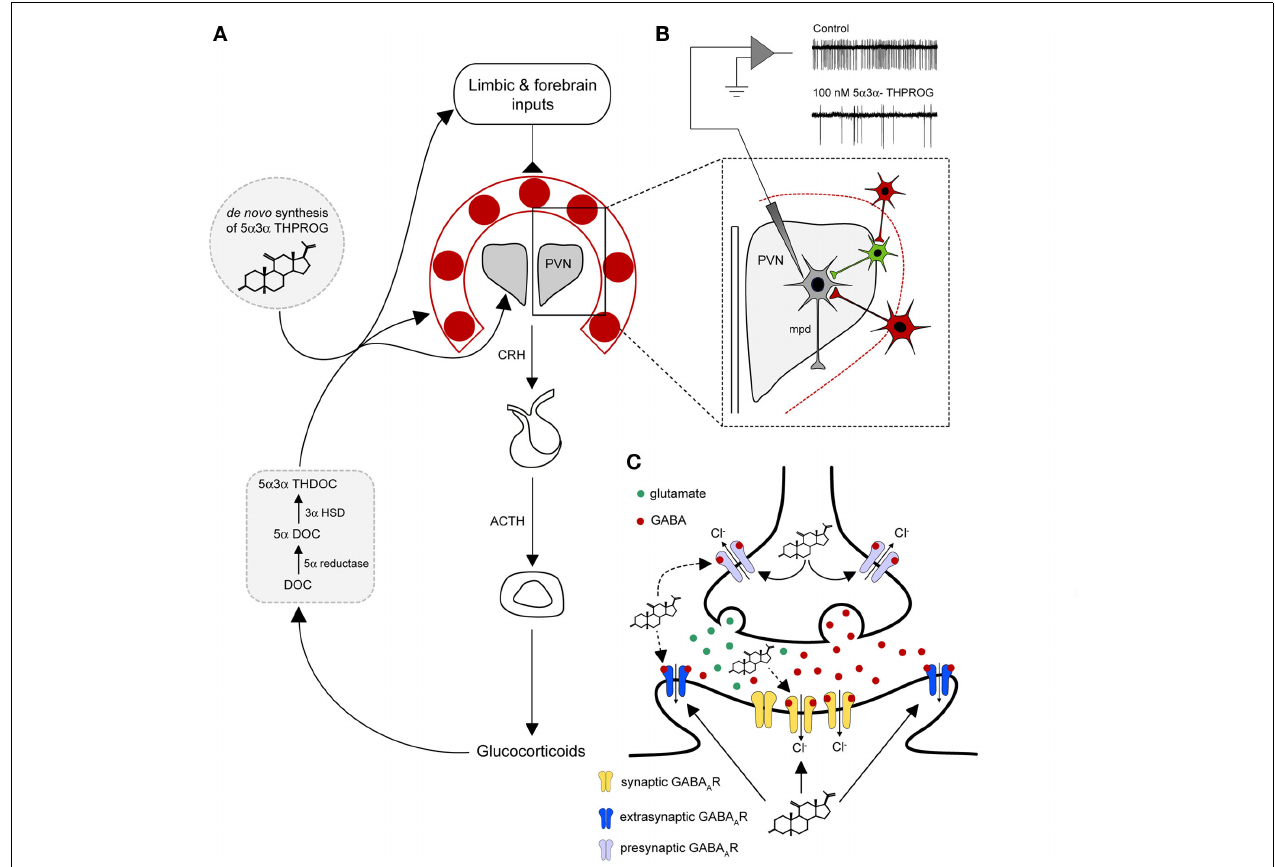
currents recorded fromWT mpd neurons in a hypothalamic slice preparation containing the PVN and surrounding structures, thus inhibiting their